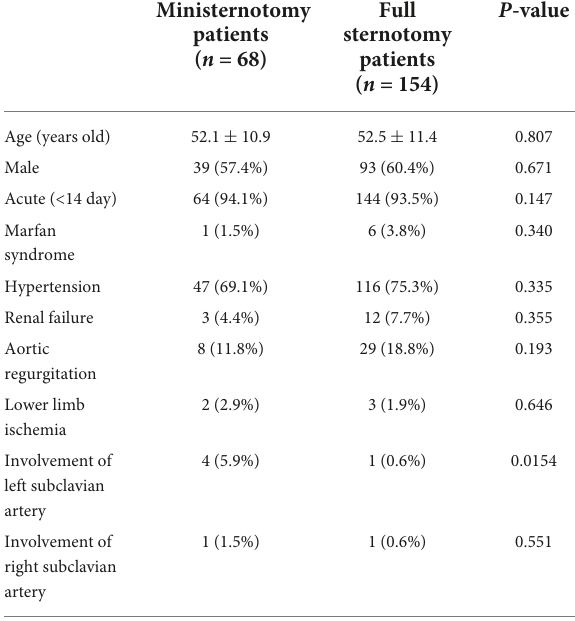
TABLE 1 Baseline and procedural